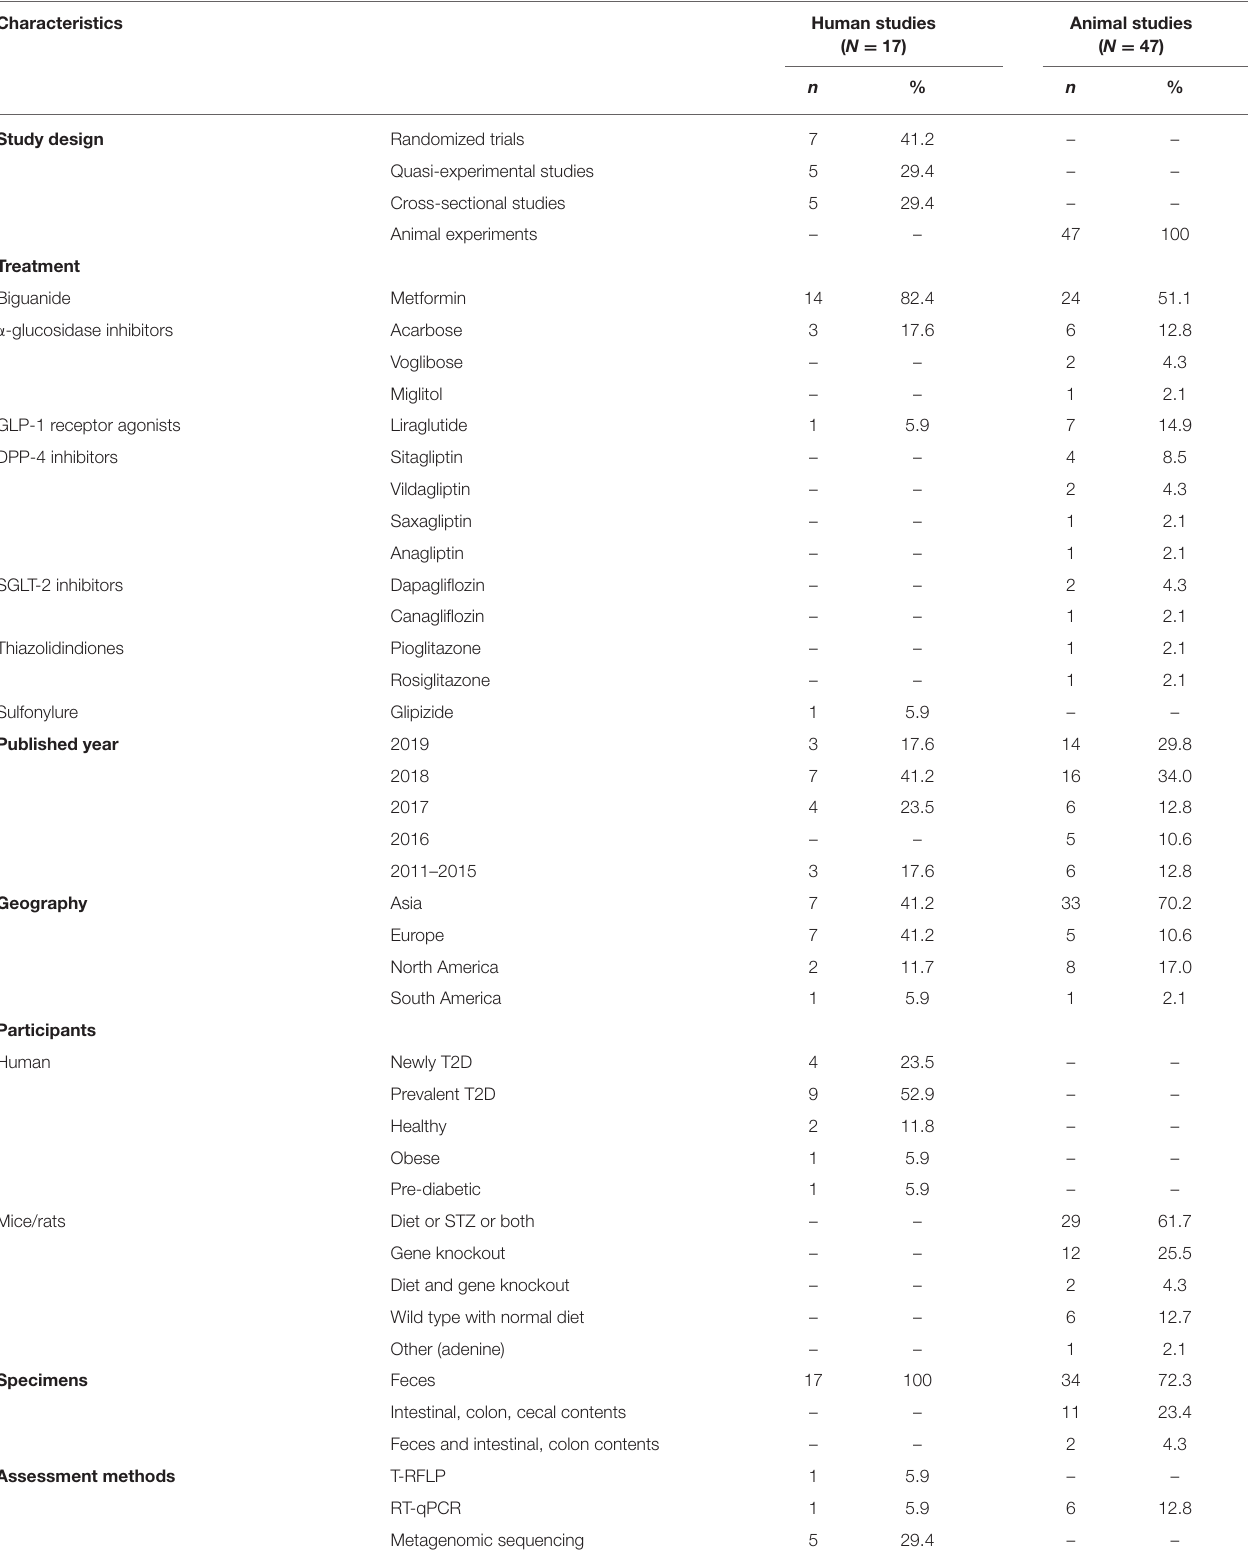
TABLE 1 | General characteristics of all included